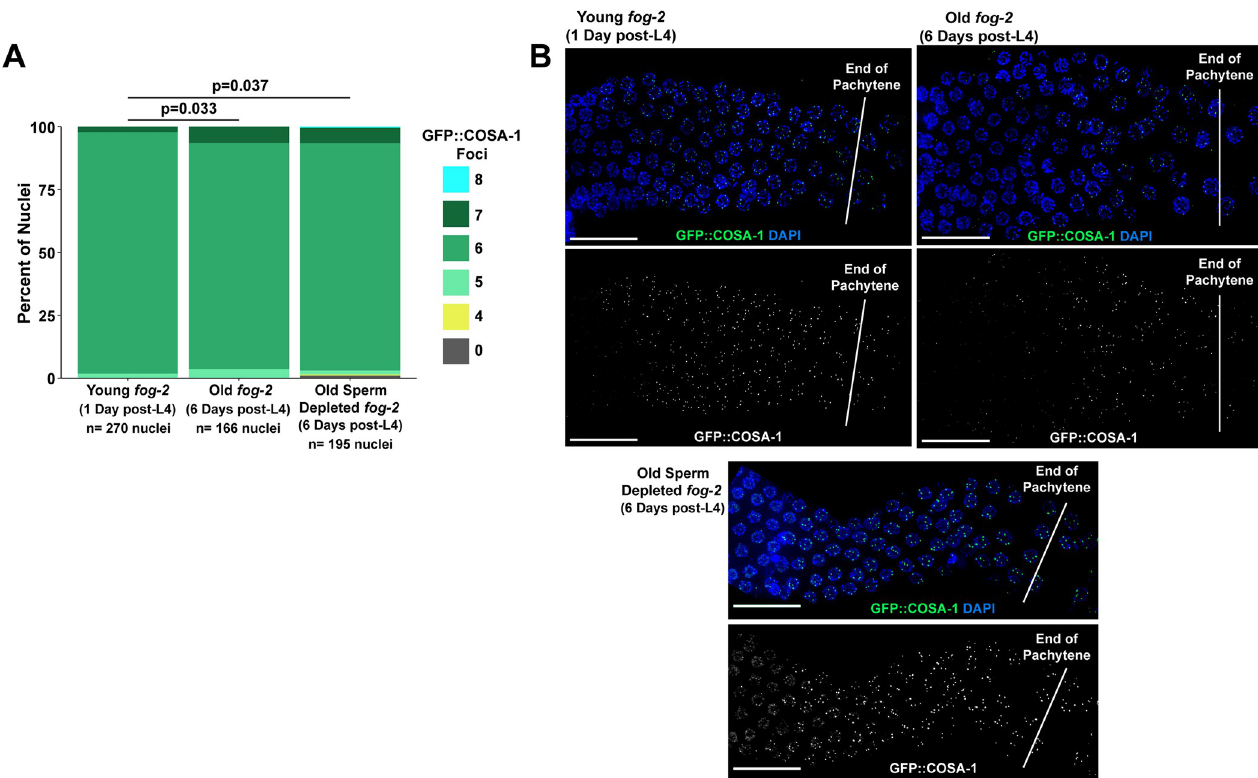
Fig 4. Crossover designation is altered in aged fog-2 germlines. A) Stacked bar plot of the percent of nuclei in young (1 day post L4) and old (6 days post L4) unmated or sperm depleted fog-2 mutants with the given number of GFP::COSA-1 foci. See Fig 2A for an outline of the maintenance schemes used in each of these cohorts. The p value displayed was calculated by Chi Square test comparing the proportion of nuclei with > 6, 6, or < 6 COSA-1 foci. N values indicate the number of nuclei scored. B) Representative images of GFP::COSA-1 localization in young and old fog-2 mutant germlines. Scale bars represent 20 μ m. Germlines are oriented with the proximal end on the left and distal end on the right. Vertical low opacity white lines designate the end of pachytene. Numerical data associated with this figure is presented in S4